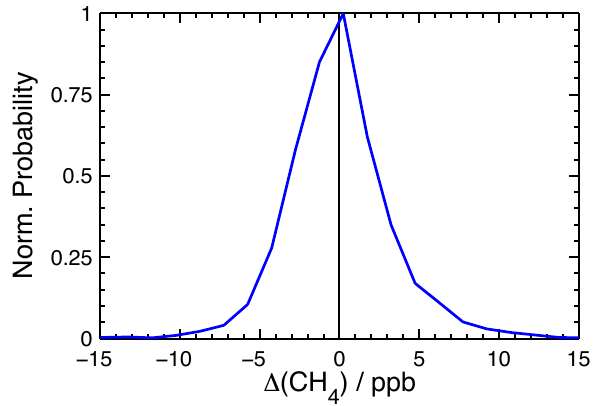
Fig. 9. PDF of the airborne accuracy expressed as deviation of the individual airborne calibration measurements from the linear calibration function for each flight. On average the accuracy is found to be ∆ CH 4 ∼ 3 . 4 ppb ( 1 σ ) at the aircraft cruising altitude.